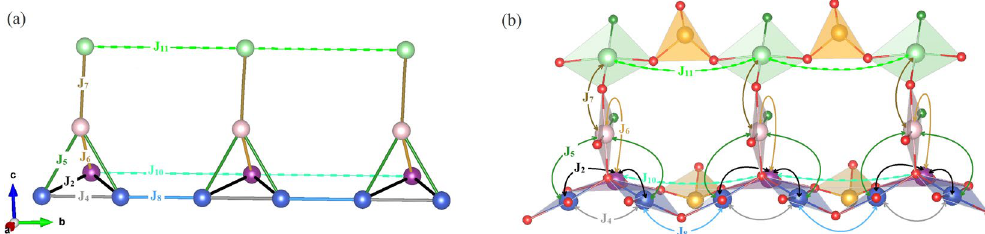
Figure 7. ( a ) Magnetic model used in the QMC simulations. ( b ) Exchange interactions within the crystal